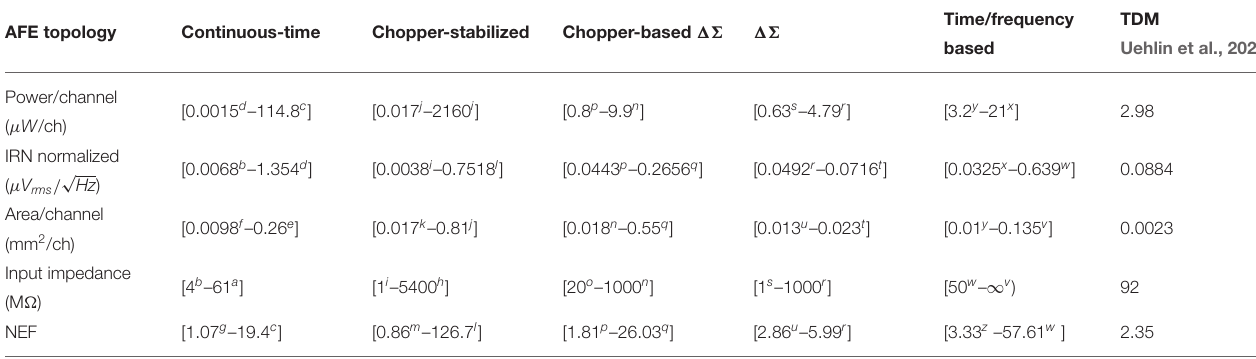
TABLE 2 | Comparison of high-performance AFEs (range of